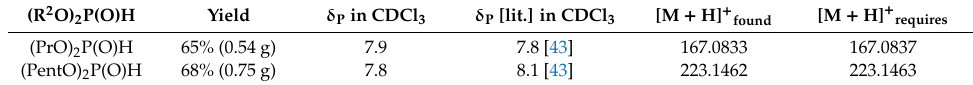
Table 5. Yield, 31 P NMR and MS data for the dialkyl phosphites